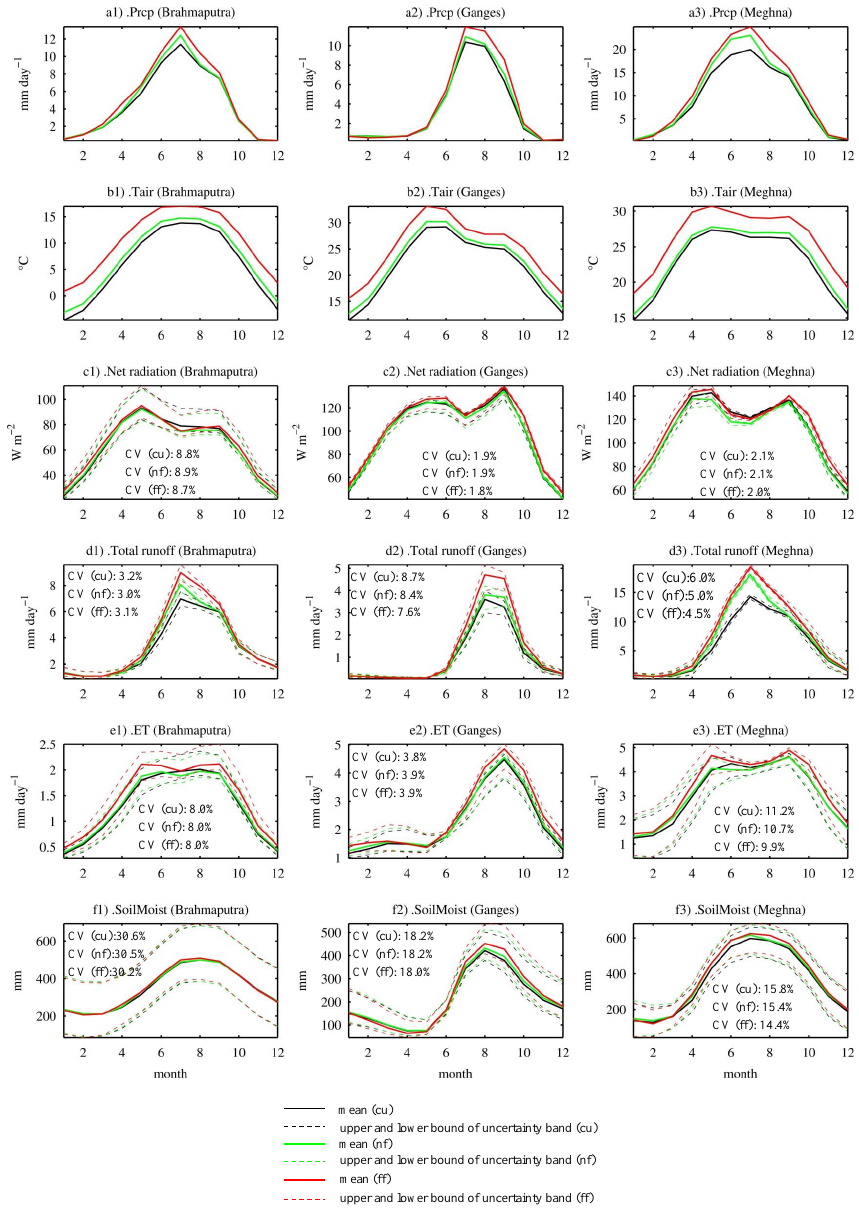
Figure 8. (a1) – (f3) The mean (solid line), upper and lower bounds (dashed line) of the uncertainty band of the hydrological quantities and net radiation components for the present-day (black), near-future (green) and far-future (red) simulations as determined found from 10 simulation results considering 10 optimal parameter sets according to NSE (cu: present-day, nf: near-future, ff: far-future). Coefficients of variations (CVs) for all periods (Table 7) are noted in each